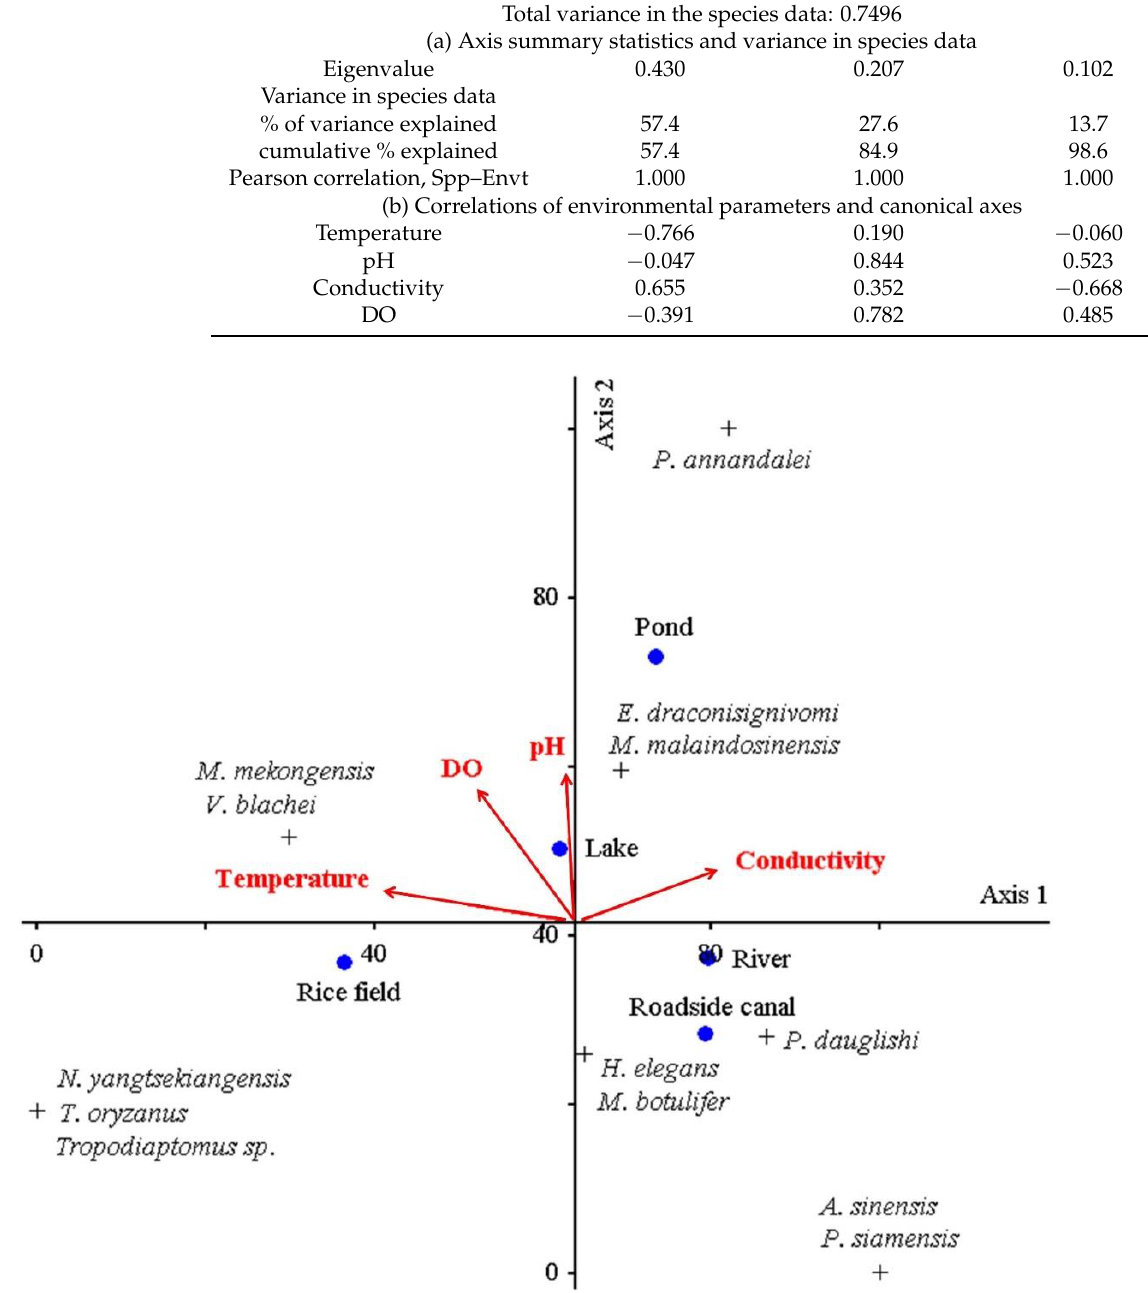
Figure 6. Ordination diagram based on canonical correspondence analysis (CCA) of copepod species scores concerning environmental variables (the Monte Carlo test; p = 0.036, Eigenvalue axis 1 = 0.419, Eigenvalue axis 2 = 0.187). Filled circles represent habitats, plus symbols represent species, and arrowed lines represent environmental variables.